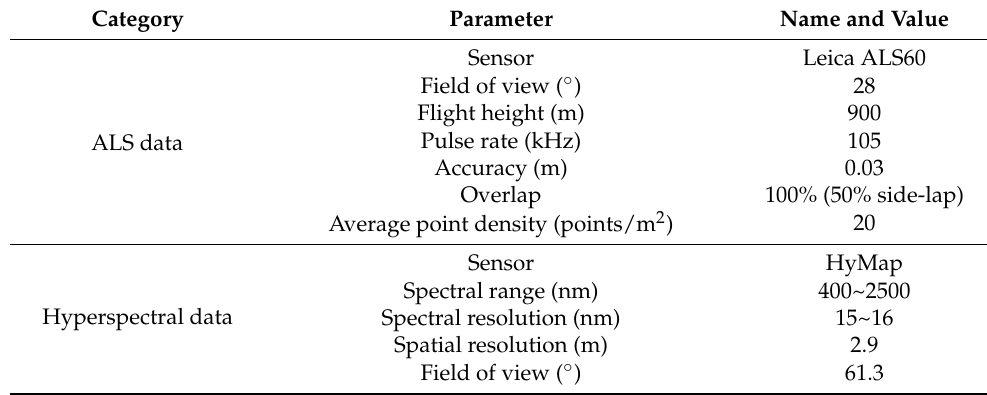
Table 1. ALS and hyperspectral data-acquisition parameters.